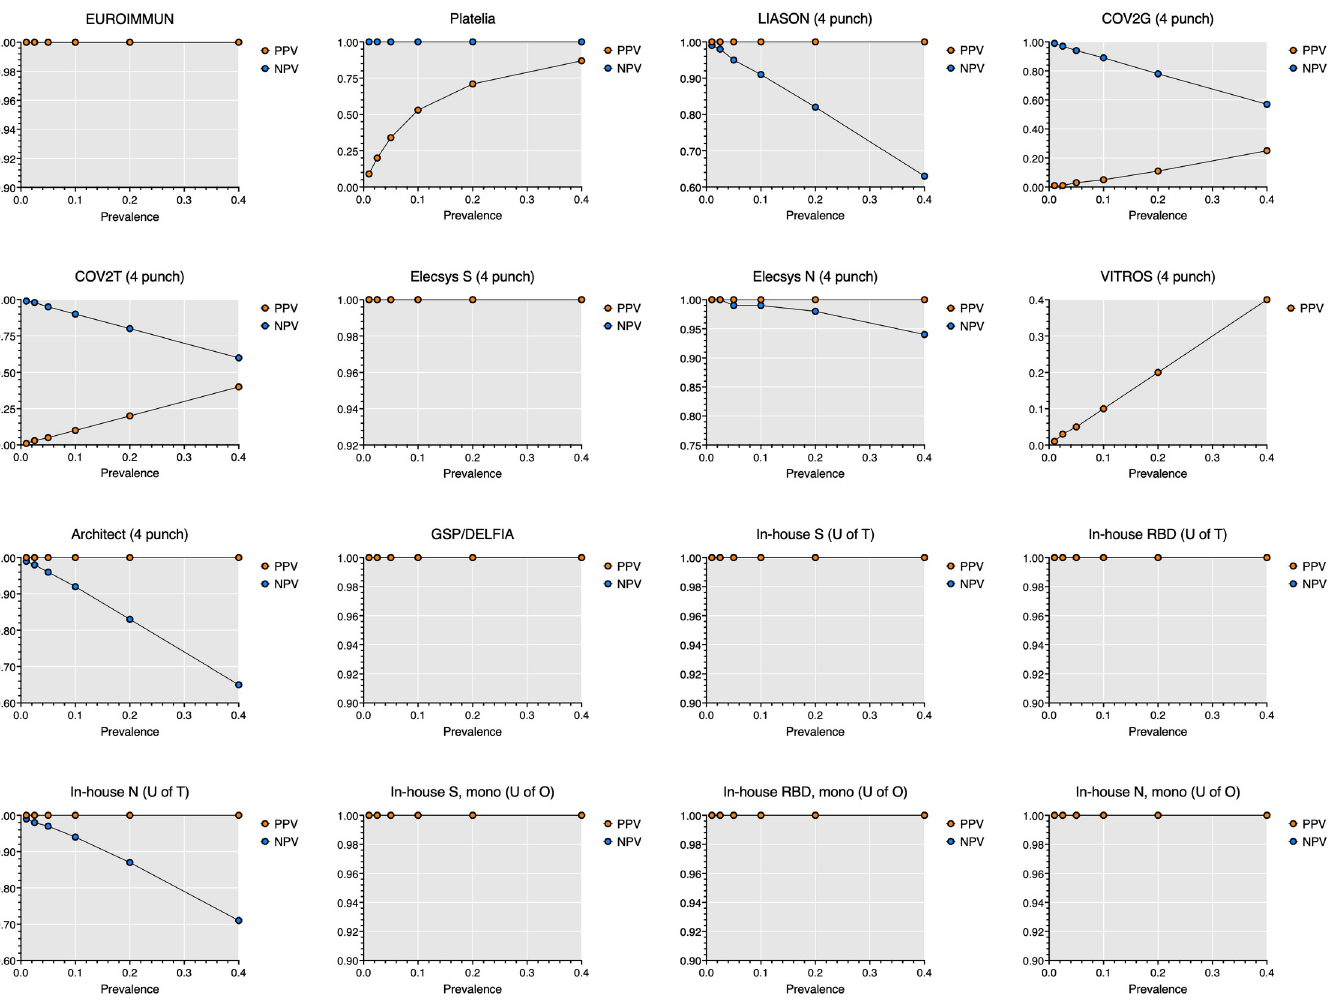
Fig 1. Positive predictive values (PPV) and negative predictive values (NPV) by prevalence for each commercial and in-house assay on dried blood spot specimens. PPV and NPV is presented for n = 10 SARS-CoV-2 antibody negative DBS specimens and n = 10 SARS-CoV-2 antibody positive DBS specimens. One 6 mm (1/4 inch) punch was used for the EUROIMMUN assay and two 6 mm (1/4 inch) punches were used for the Platelia and in-house assays. Data from four 6 mm (1/4 inch) punches is presented for all other assays. EUROIMMUN = Anti-SARS-CoV-2 ELISA assay (EUROIMMUN, Lu¨beck, Germany). Platelia = SARS-CoV-2 assay (Bio-Rad, Hercules, California). LIASON = SARS-CoV-2 assay (DiaSorin, Saluggia, Italy). COV2G = SARS-CoV-2 COV2G assay (Siemens, Erlangen, Germany). COV2T = SARS-CoV-2 COV2T assay (Siemens). Elecsys S = Quantitative Anti-SARS-CoV-2 assay (Elecsys spike; Roche, Basel, Switzerland). Elecsys N = Anti- SARS-CoV-2 assay (Elecsys nucleocapsid; Roche). VITROS = Anti-SARS-CoV-2 assay (Ortho Clinical Diagnostics, Raritan, New Jersey). Architect = SARS-CoV-2 assay (Abbott, Mississauga, Canada). GSP/DELFIA = Anti-SARS-CoV-2 assay (PerkinElmer, Waltham, Massachusetts). In-house S (U of T) = In-house spike assay (University of Toronto). In-house RBD (U of T) = In-house RBD assay (University of Toronto). In-house N (U of T) = In-house nucleocapsid assay (University of Toronto). In-house S, mono (U of O) = In-house monoclonal spike assay (University of Ottawa). In-house RBD, mono (U of O) = In-house monoclonal RBD assay (University of Ottawa). In-house N, mono (U of O) = In-house monoclonal nucleocapsid assay (University of Ottawa). The VITROS assay could not achieve a specificity greater than 0% therefore, only PPV is